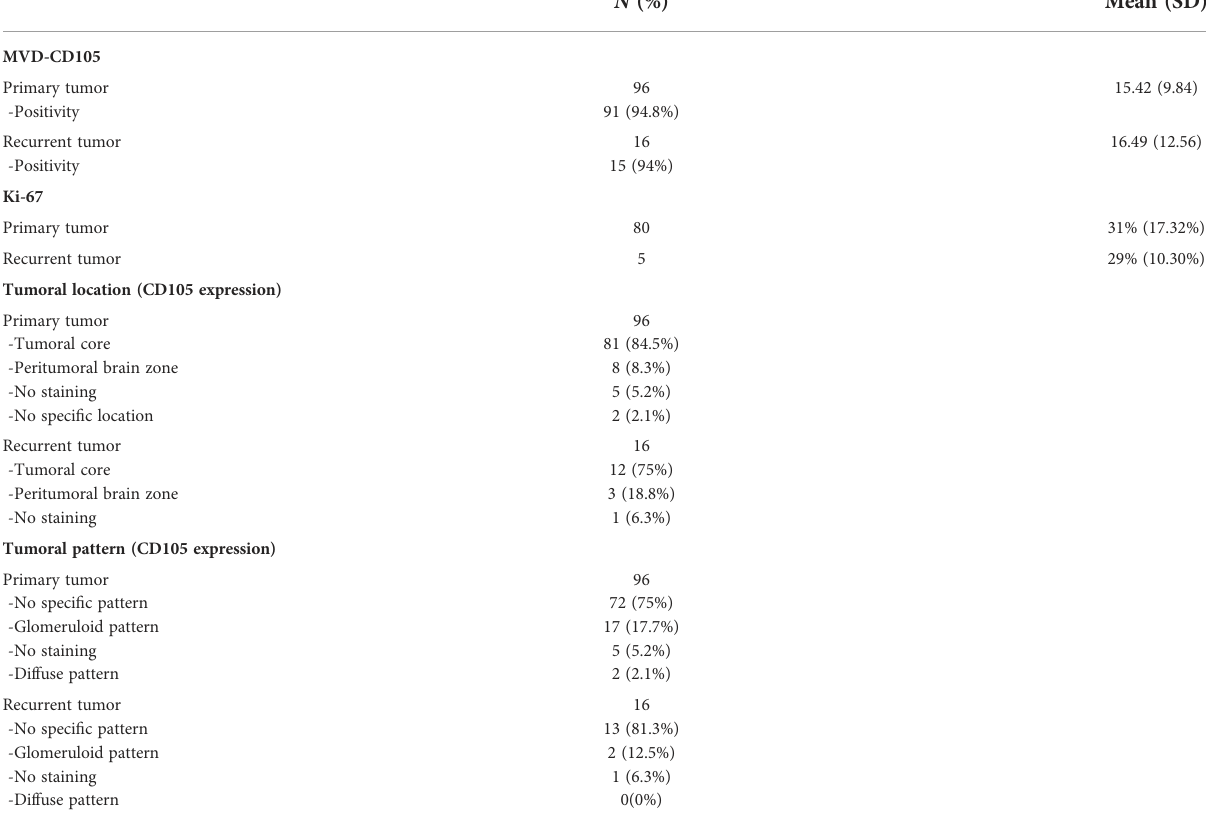
TABLE 3 MVD-CD105, Ki-67, tumoral pattern, and location of CD105 expression.